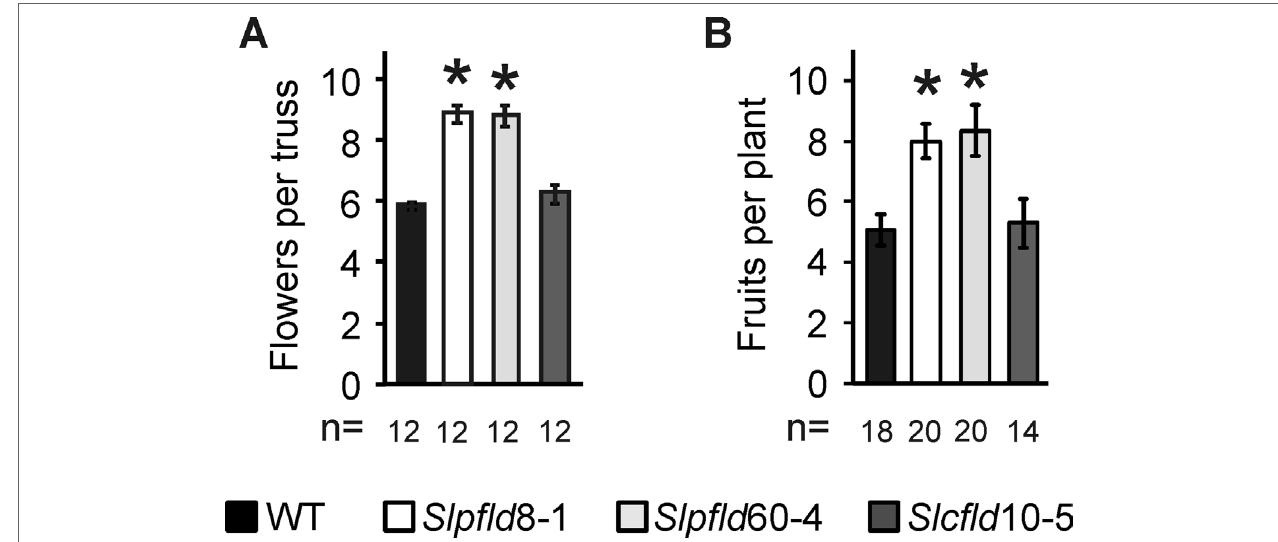
FIgURE 4 | Flavodoxin expression in chloroplasts enhanced flower number and fruit production. (A) Flowers were counted in the three to five initial trusses from each plant. (B) Total fruit numbers per plant included fully ripe, breaker, and green fruit collected up to 120 days post-germination. Data are means ± SEM of n biological replicates, with n indicated below each line. Statistically significant differences are shown by asterisks and were determined using one-way ANOVA and Tukey's multiple comparison test ( P < 0.05).